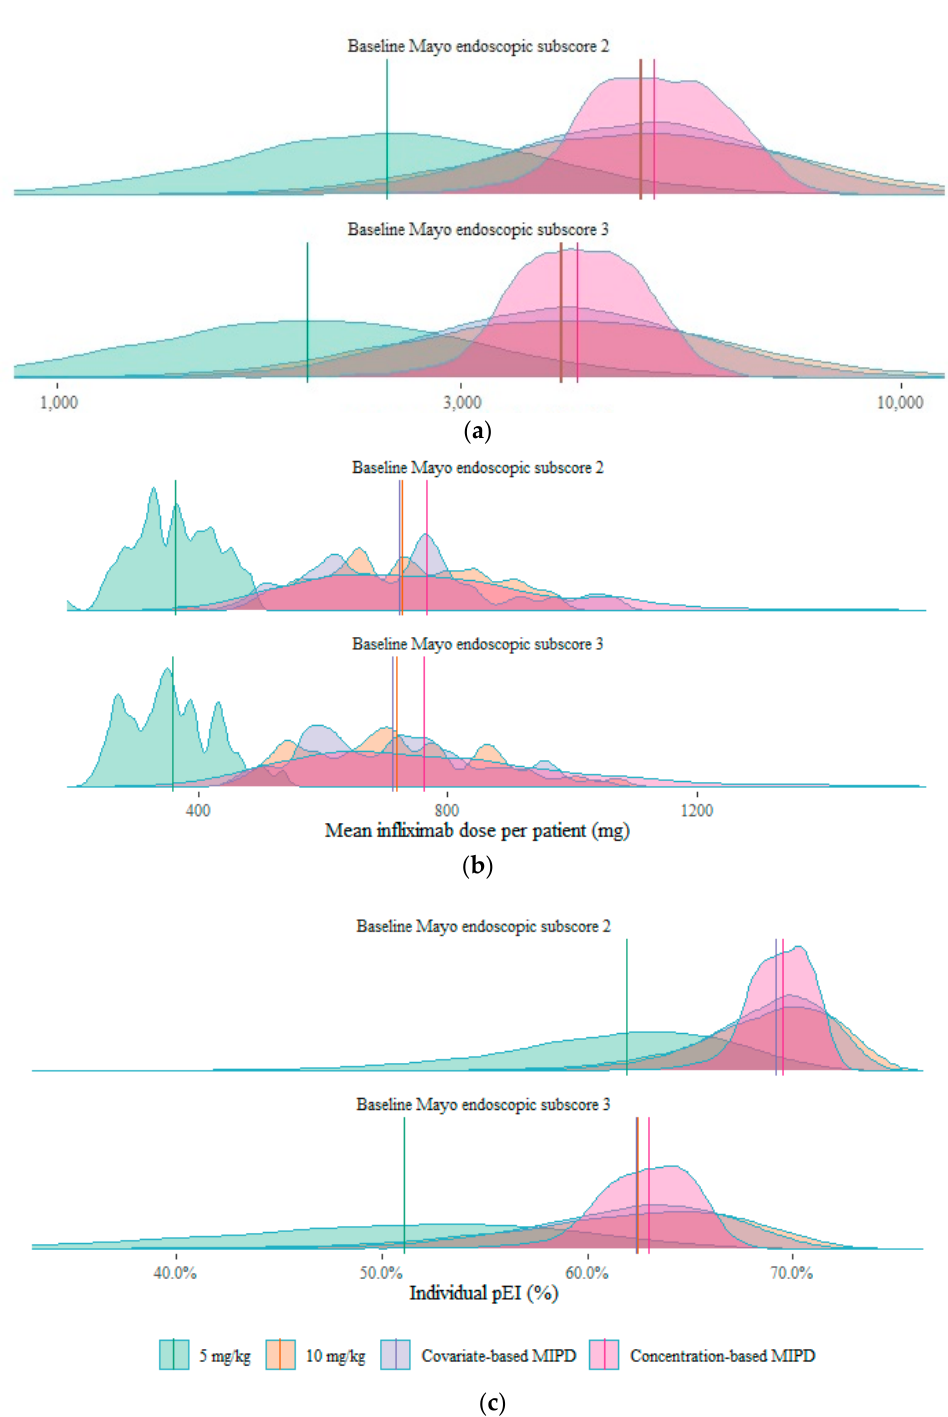
Figure 2. ( a ) Density plots of exposure in each of the four dosing scenarios, per baseline Mayo endoscopic subscore. Vertical lines show median exposure per scenario. ( b ) Density plots of the mean doses in each of the four dosing scenarios, per baseline Mayo endoscopic subscore. Vertical lines show overall mean dose per scenario. ( c ) Density plots of the individual probability of endoscopic improvement in each of the four dosing scenarios, per baseline Mayo endoscopic subscore. Vertical lines show overall mean pEI per scenario. CAUC, cumulative area under the curve; MIPD, model-informed precision dosing; pEI, probability of endoscopic improvement.